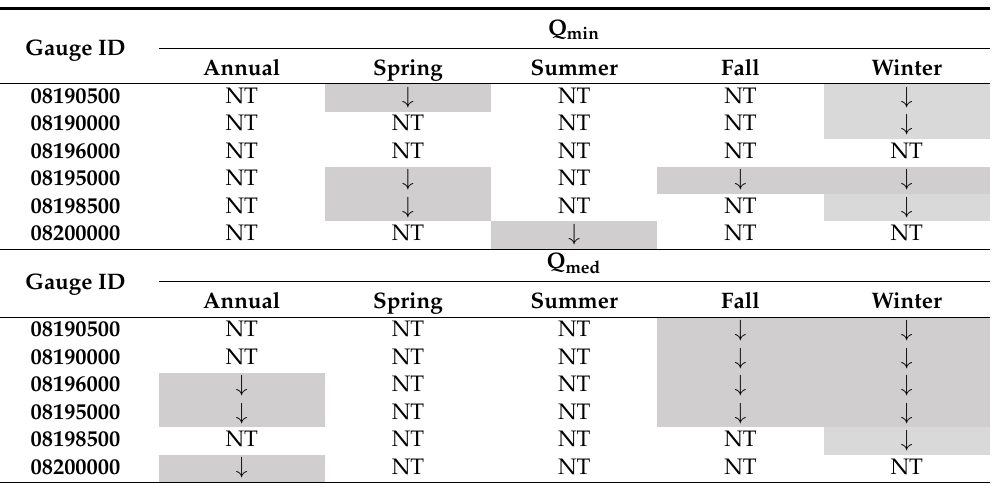
Table 4. Annual and seasonal NRB streamflow trends from 1994 to 2014 ([NT] no significant trend; [ ↓ ] statistically significant decreasing